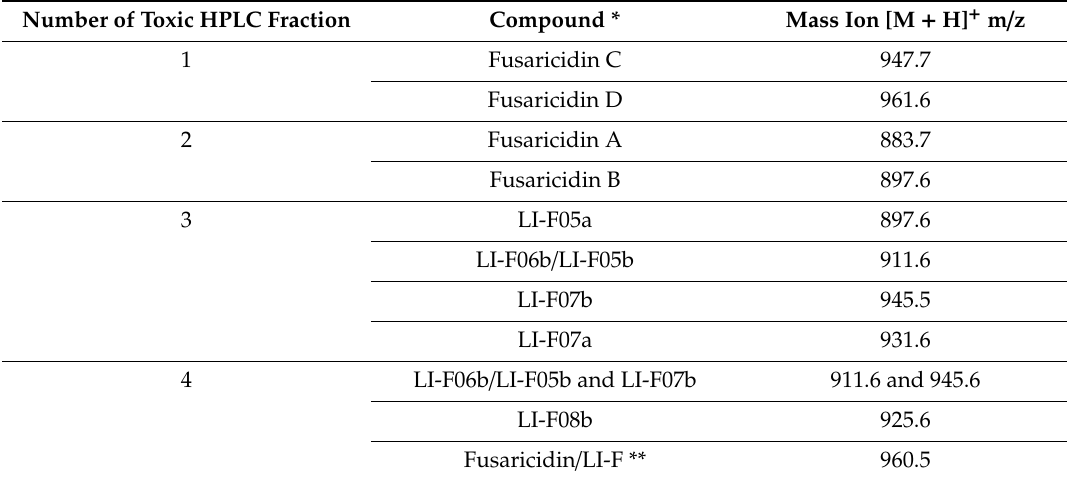
Table 1. FTCs (fusaricidin-type compounds) found in HPLC fractions 1–4 of ethanol extracts of P. polymyxa strains RS10 and I / Sim.